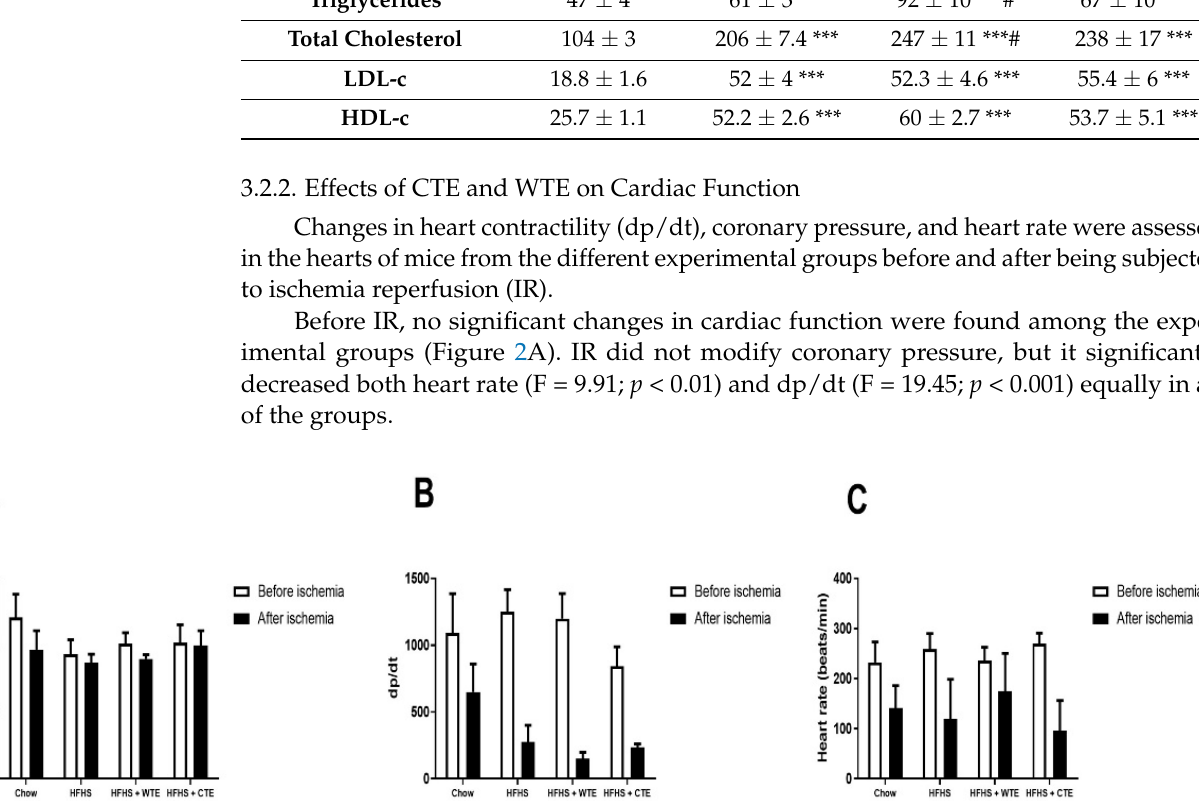
Figure 2. Changes in coronary perfusion pressure ( A ), contractility ( B ) and heart rate ( C ) before and after coronary ischemia-reperfusion in hearts from mice fed a standard diet (Chow), a high-fat diet/sucrose diet (HFHS), a high-fat diet/sucrose diet supplemented with White Tea Extract (HFHS+WTE), or a high-fat diet/sucrose diet supplemented with Tea Complex Extract (HFHS+TCE).